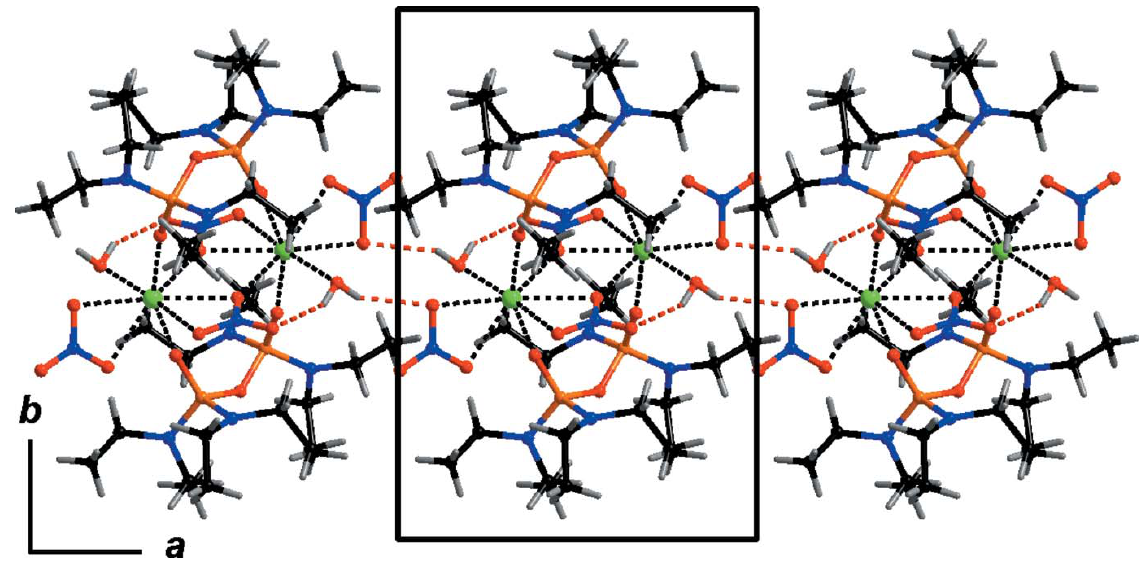
Figure 2 Intermolecular and intramolecular N—O (cid:2)(cid:2)(cid:2) H—O hydrogen bonding (red broken-off bonds) that create the packing chains along the a -axis direction, viewed along the c axis. Dashed black bonds highlight the eight-coordination around the Ca 2+